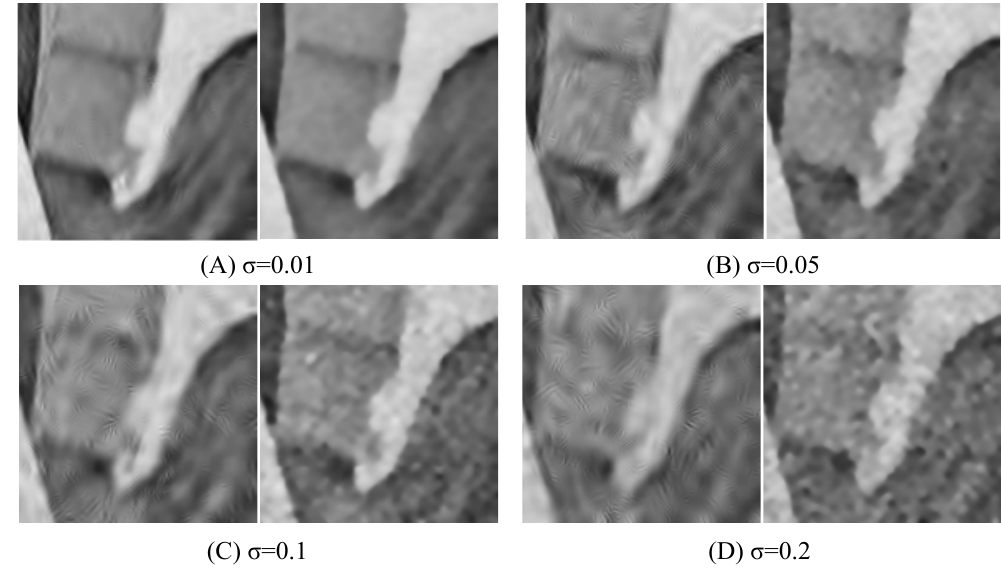
Figure 13. The edge information comparison of DTCWT and proposed method: left image is denoised by DTCWT, and right is proposed method. ( A ) Part of lena of noise σ = 0.01; ( B ) Part of lena of noise σ = 0.05; ( C ) Part of lena of noise σ = 0.1; ( D ) Part of lena of noise σ = 0.2.